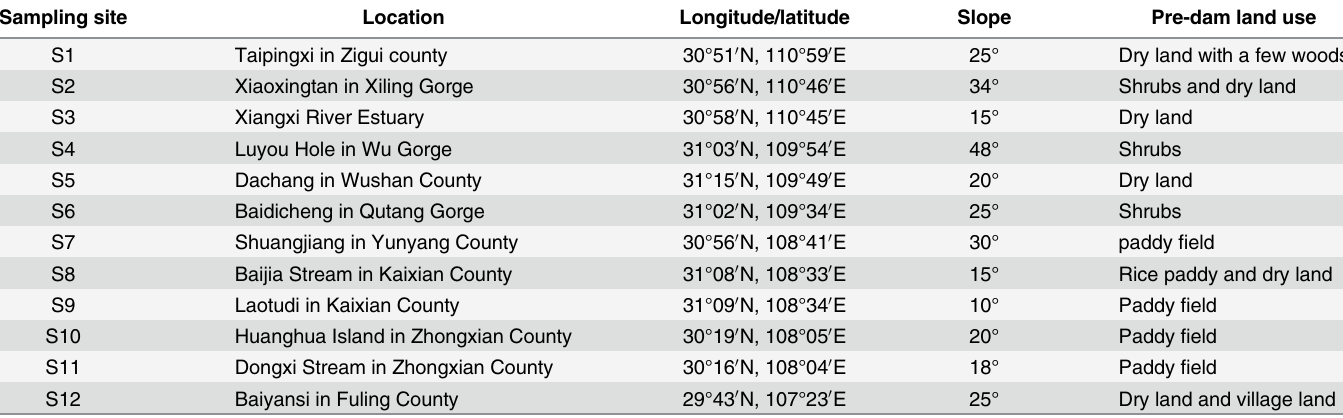
Table 2. General environmental characteristics of the twelve sampling sites in the drawdown area of the Three Gorges Reservoir, as previously reported in [13]. Sampling